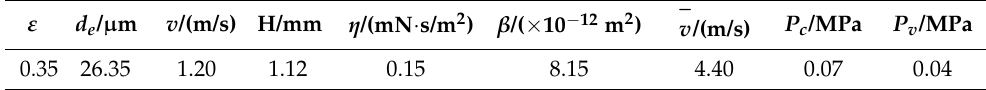
Table 1. The parameters and calculated